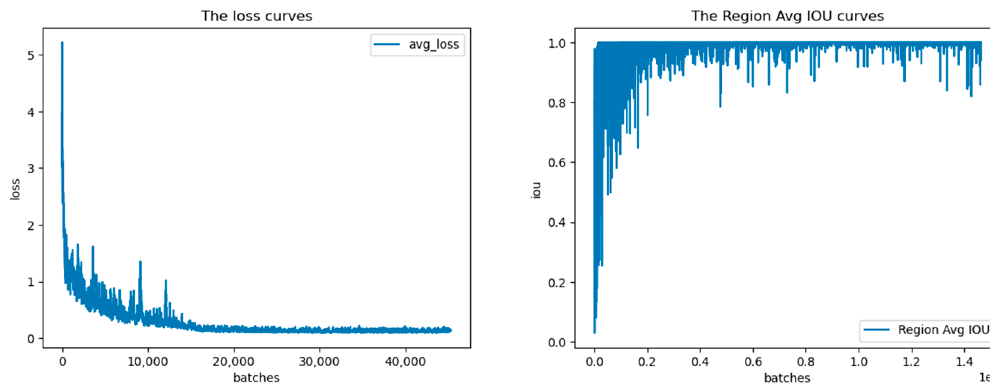
Figure 11. Model training results.